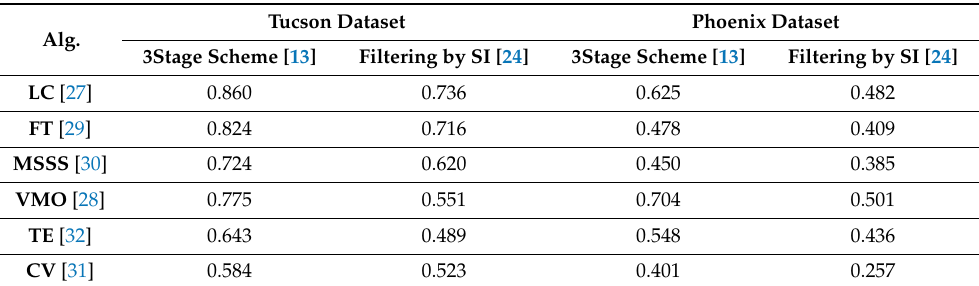
Table 1. Average F-score for three-stage post-processing scheme vs. filtering by SI. Tucson Dataset Alg.